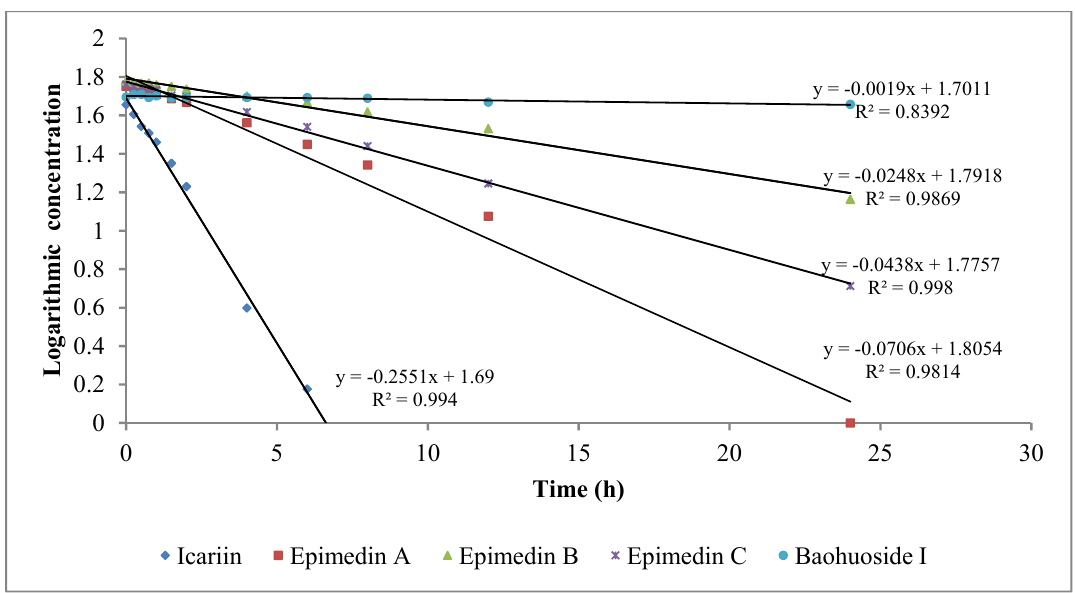
Figure 3. The metabolic rates of flavonoids by intestinal enzyme of rats.